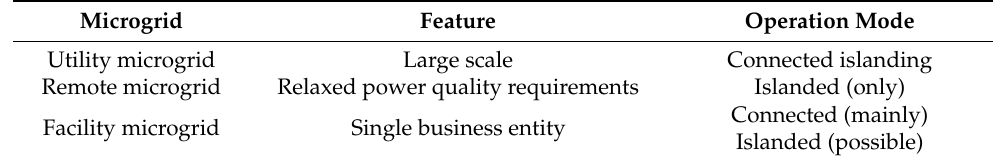
Table 1. Types of microgrids.